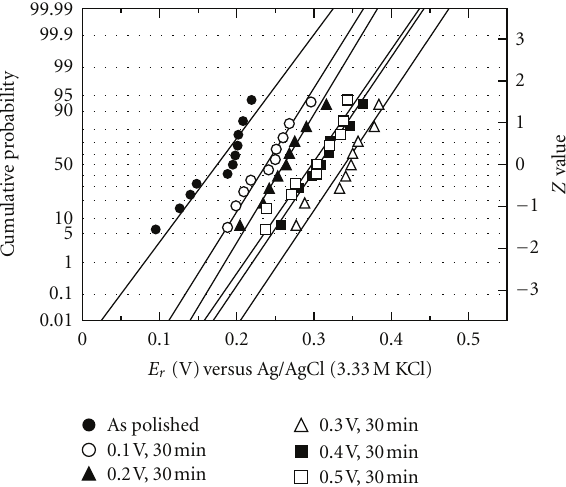
pitting, E r , in 0.5M NaCl for commercial Type 316L stainless steels after polarization treatments at di ff erent potentials for 30min in 1M Na 2 SO 4 of pH 3.